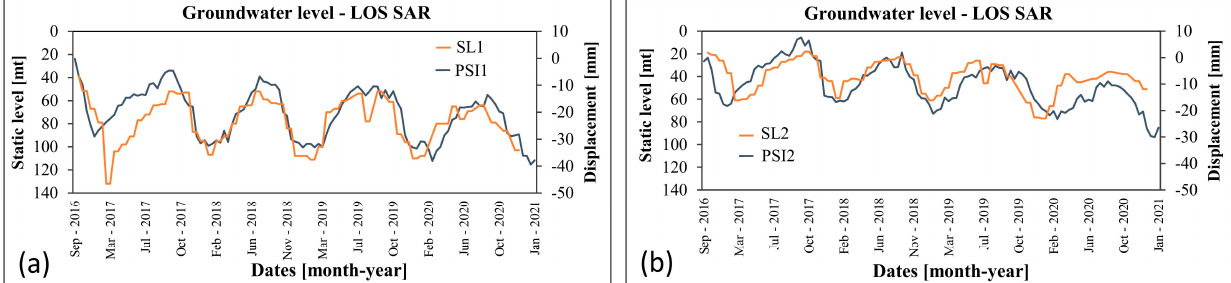
Figure 11. Deformation area and location wells of Sanitary Services Company (ESSBIO), back- ground image Sentinel 2 ESA (2022), yellow dots Well 1 (W1) and Well 2 (W2).